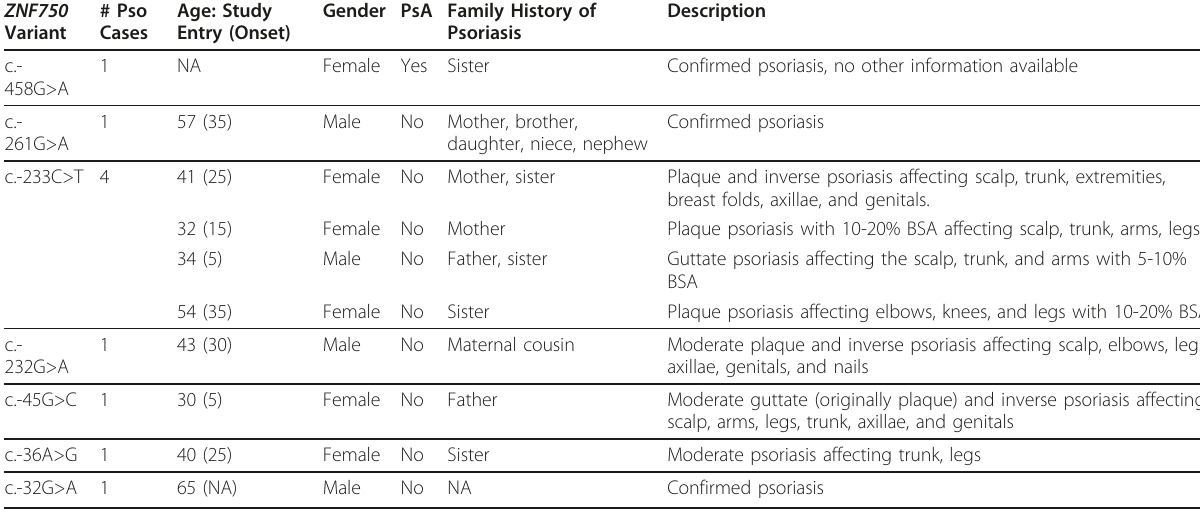
Table 5 Clinical characteristics of subjects with rare ZNF75 0 variants in the 5 ’ regulatory region ZNF750